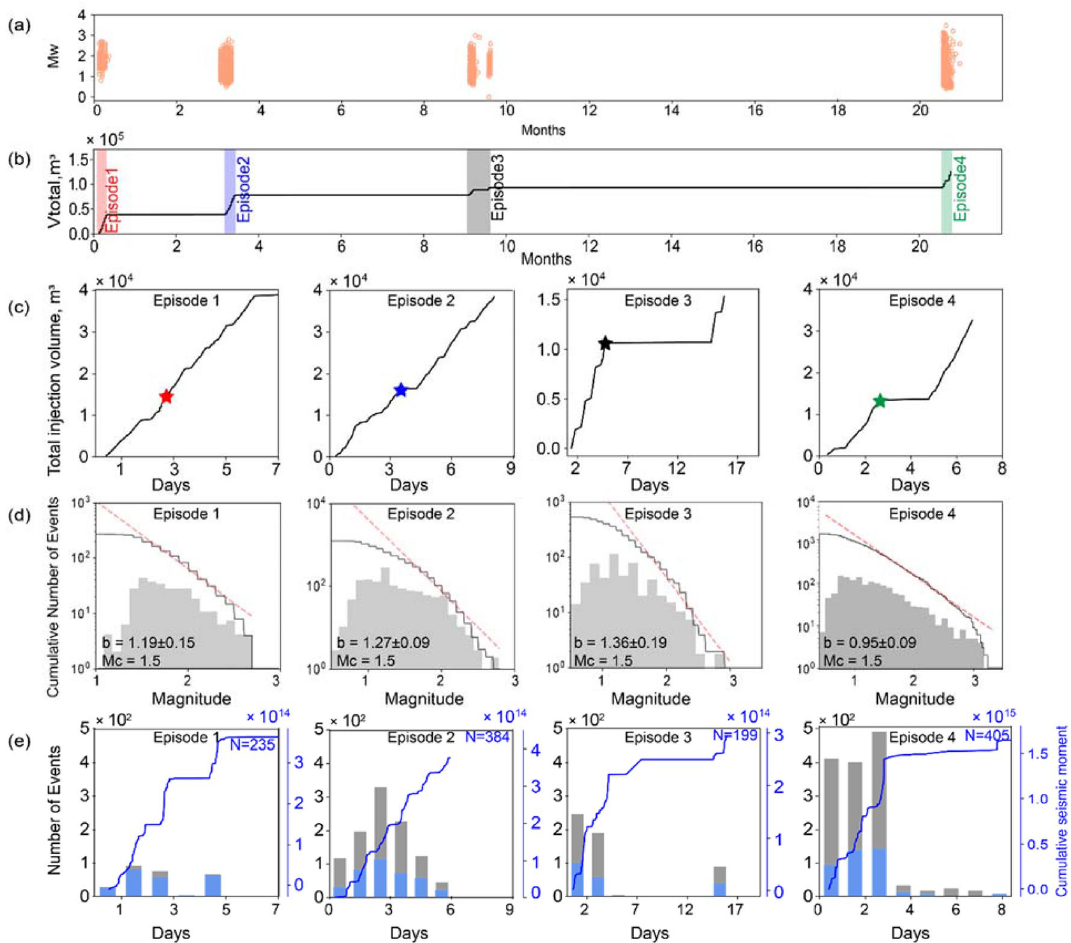
Figure 3. Seismic and injection history of project area two. ( a ) The moment magnitude ( M W ) of seismic events during injection (orange symbol) during the same 21-month period for the project area, based on the public catalog from the BC Oil and Gas Commission. This confirms that no significant seismicity occurred in the project 2 area between the hydraulic fracturing (HF) episodes. ( b ) Injection history in project 2 includes four injection episodes (highlighted). ( c ) The cumulative injection volume versus time for each episode. The star shows the time when the maximum magnitude event occurred during each episode. ( d ) Maximum likelihood Gutenberg-Richter relation with 95% confidence for each episode, characterized by parameters M c and b . ( e ) Histogram of the number of total seismic events (grey) and seismic events of magnitude above Mc (blue) per day for each episode. The number of total seismic counts above Mc for each episode is labeled. The blue curve shows the cumulative seismic moment versus time for each